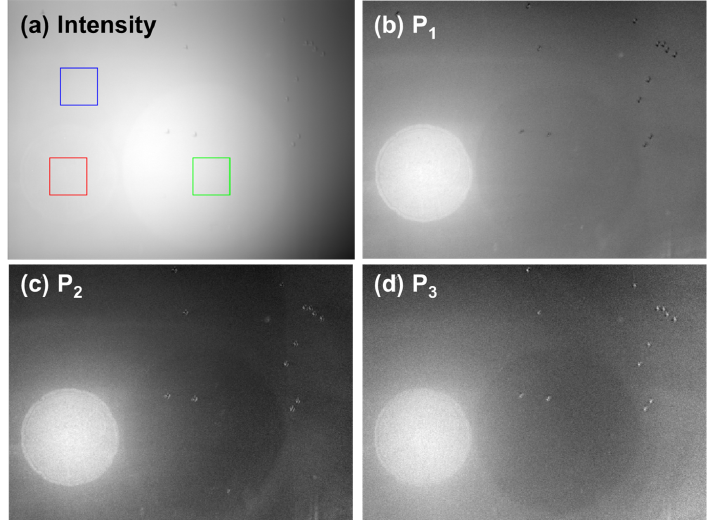
Figure 5. ( a ) Intensity (i.e., m 00 ) image and IPPs images: ( b ) P 1 , ( c ) P 2 , and ( d ) P 3 . All four images are normalized for an enhanced visual